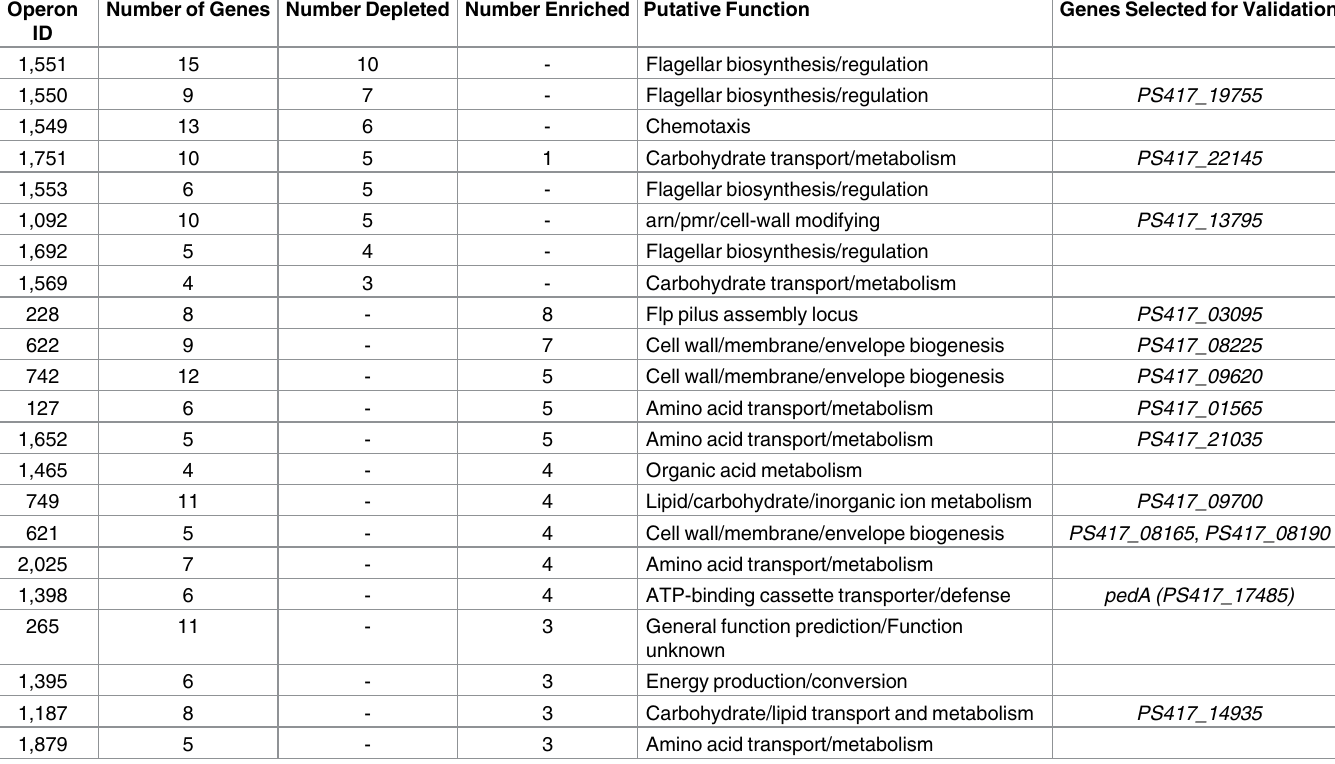
Table 1. Putative operons containing 3 or more colonization genes. All genes selectedfor validation in these operonswere successfully